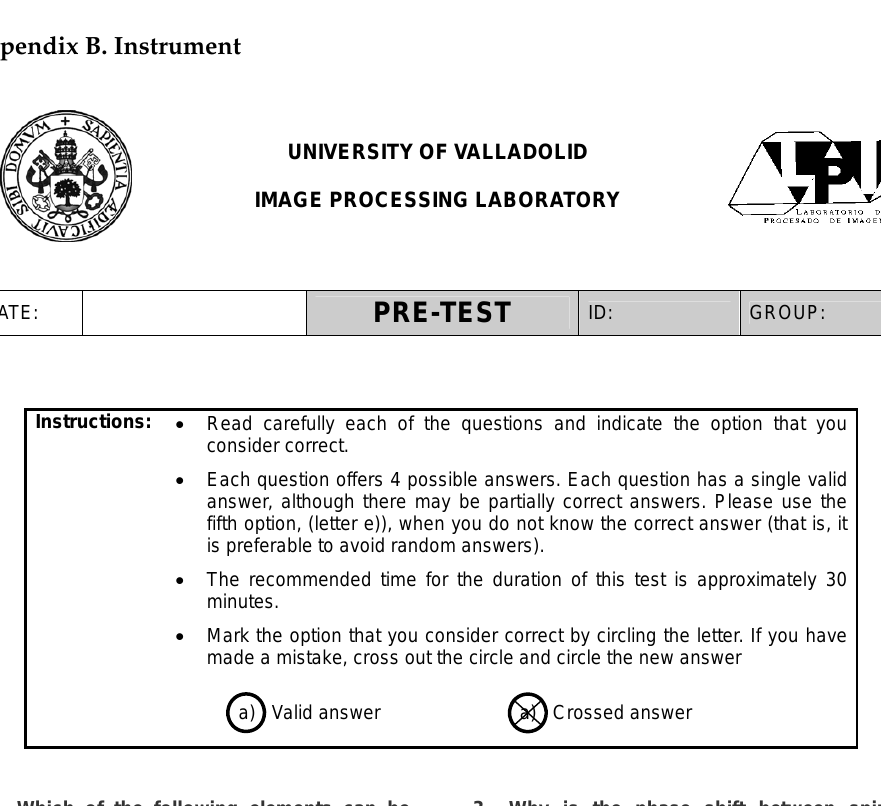
Figure A1. Instrument page 1 of